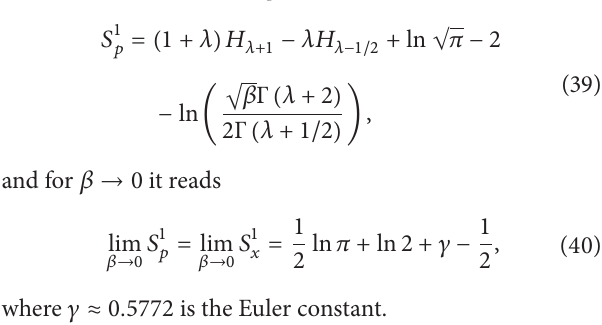
for 𝛽 → 0 , the solutions tend to the simple har- monic oscillator wave functions; that is, lim 𝛽→0 𝜓 𝑛 (𝑥) = √√𝜔/2 𝑛 𝑛!√𝜋𝑒 −𝜔𝑥 2 /2 𝐻 (√𝜔𝑥) 𝑛